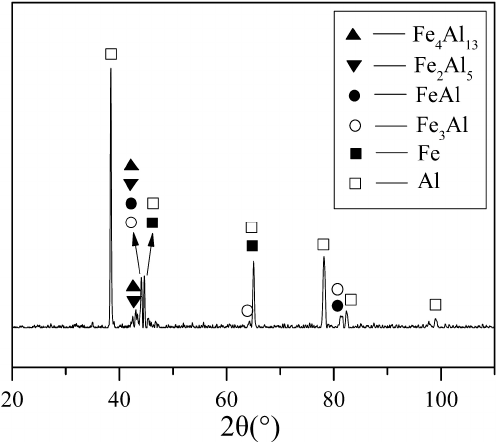
Figure 6. Interface microstructure of the joint. ( a ) Cross-sectioned macrostructure of the joint, ( b – d ) magnified views of the regions with the dotted square in ( a ), ( e ) a magnified view of the regions with the dotted square in ( d ), and ( f ) the energy-dispersive X-ray spectrometer (EDS) result of the scanning line marked with the red line in ( c ).